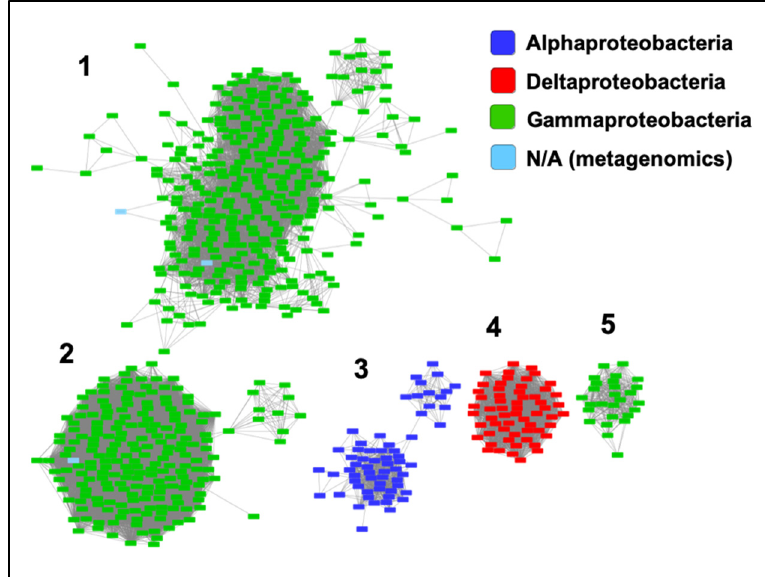
Figure 5. Relationships between ZrgA sequences. Sequence similarity network including 677 sequences filtered such that only the edges associated with E-values less than 10 − 40 are included in the network. Sequences are represented by rectangles colored according to class. The five largest clusters are indicated by numbers (1,2,3,4,5), which refer to the clusters analyzed in Supplementary Figure S3.